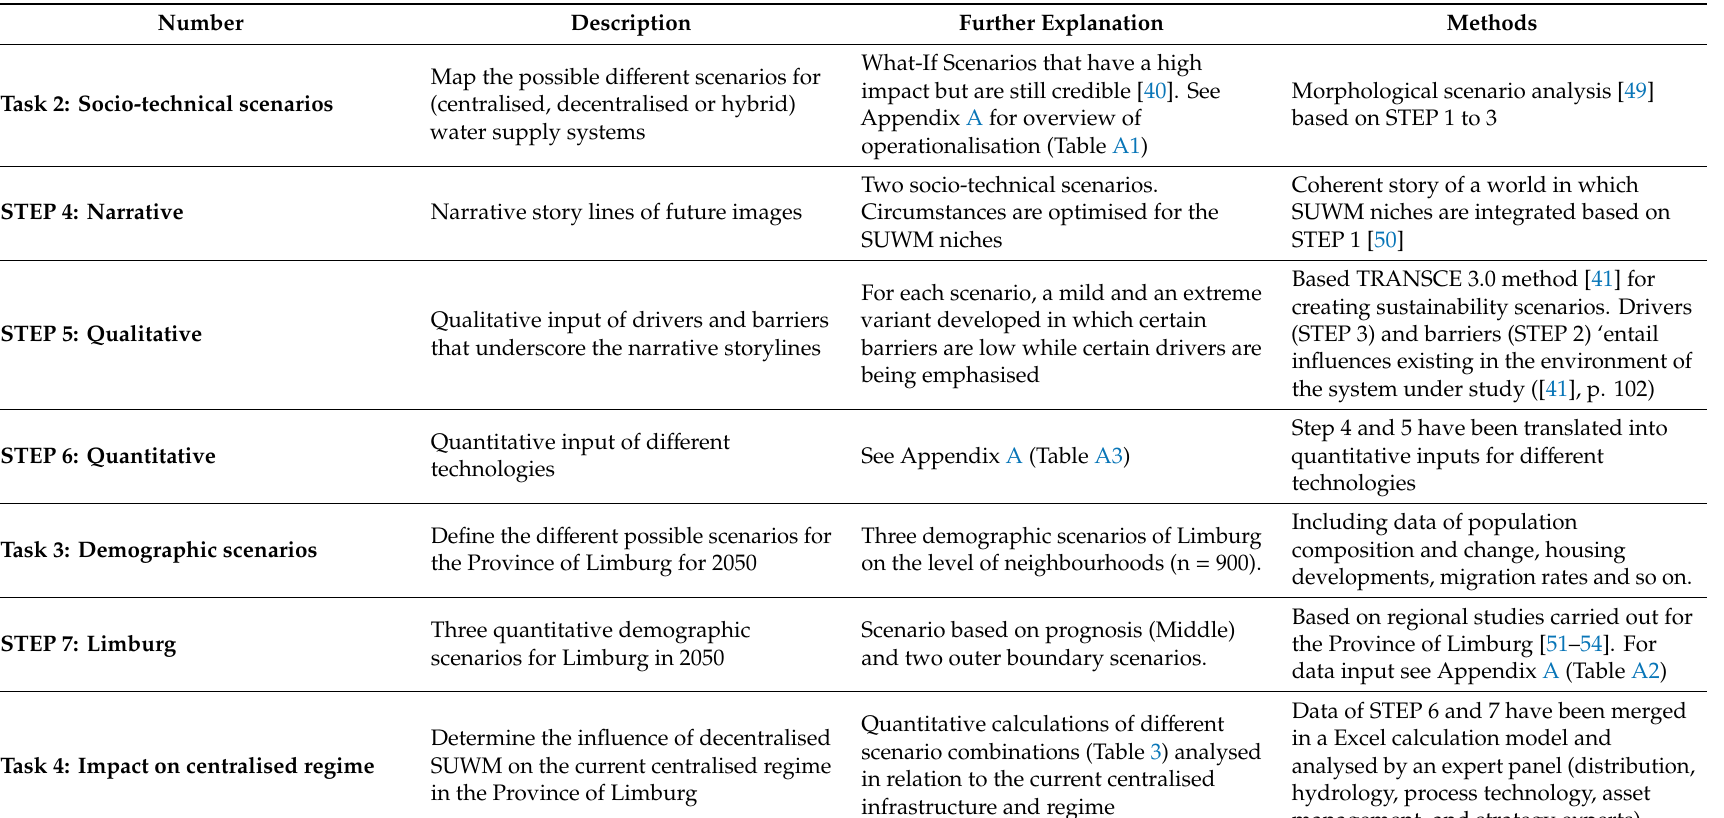
Table 2. Research approach part